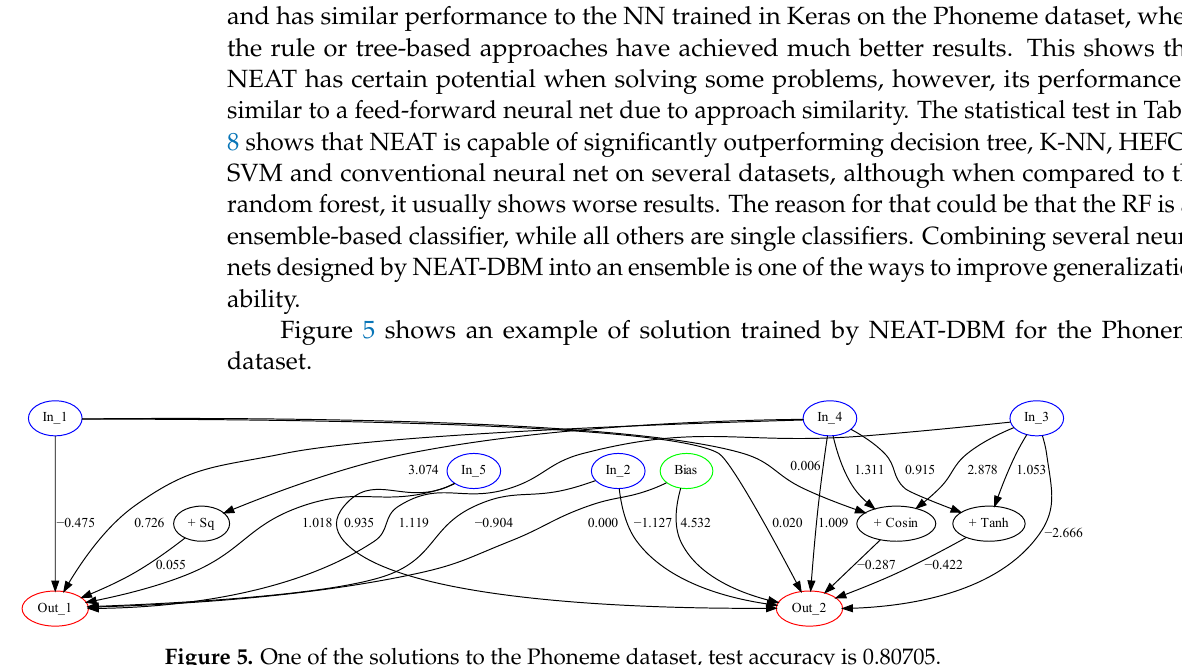
Figure 5. One of the solutions to the Phoneme dataset, test accuracy is